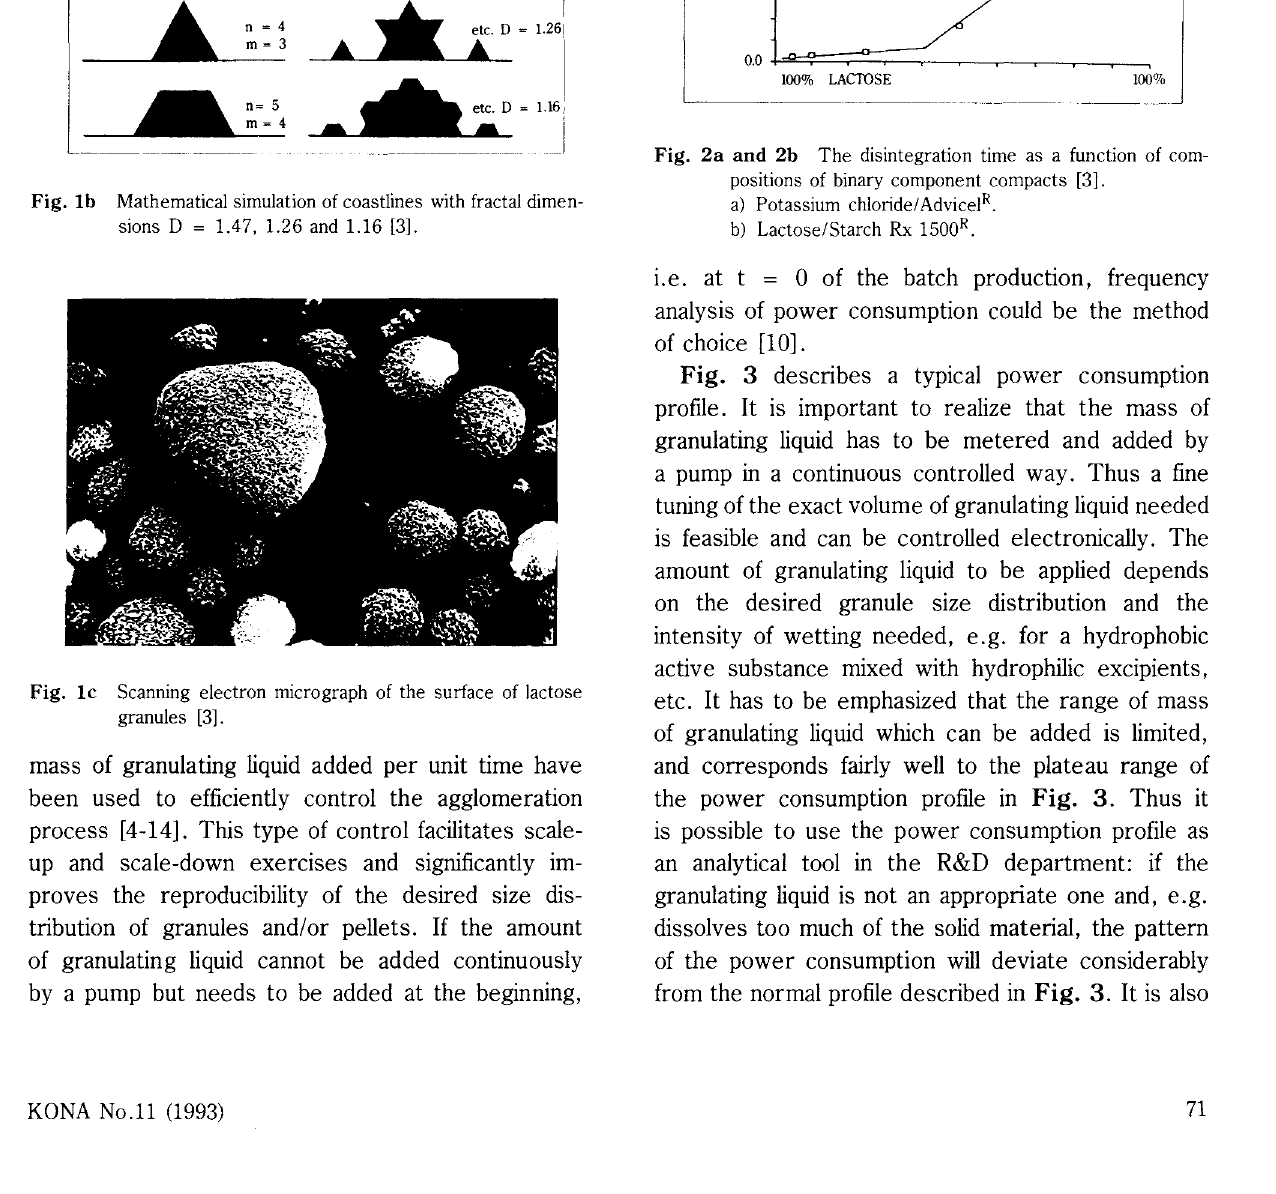
Fig. 2a and 2b The disintegration time as a function of com positions of binary component compacts [3]. a) Potassium chloride/ AdvicelR. b) Lactose/Starch Rx